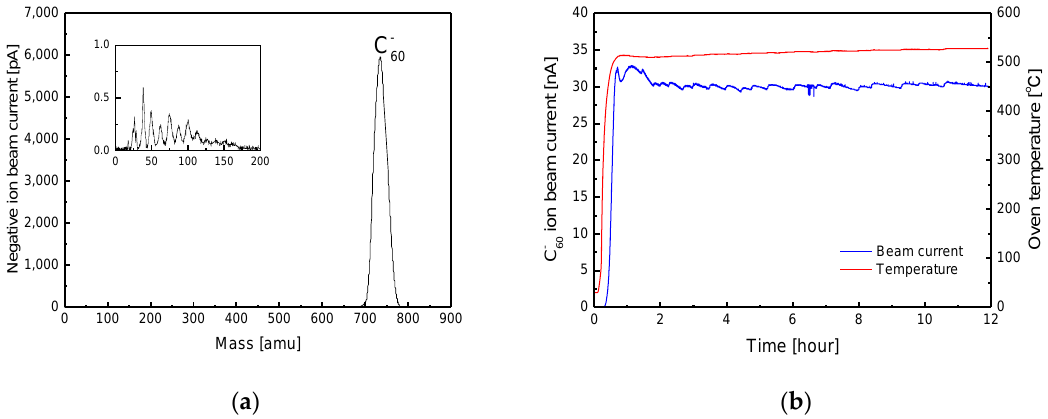
Figure 4. Example results of negative C 60 ion beam production using the oven rod: ( a ) mass spectrum of negative ions contained in beam extracted from the ion source; ( b ) negative C 60 ion beam current (blue line) and oven temperature (red line) as a function of time. The inset in ( a ) is an expanded vertical scale for a better view of the fragment